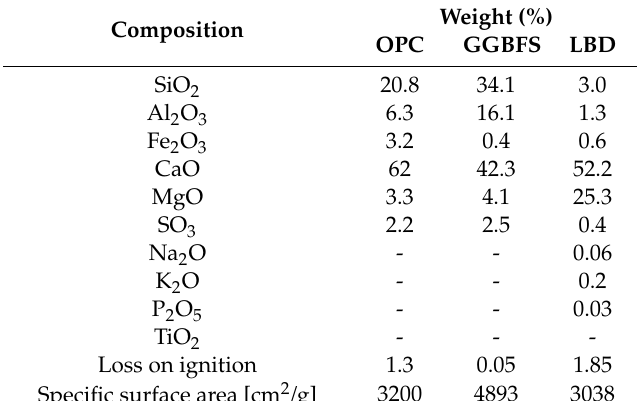
Table 1. Chemical and physical properties of Ordinary Portland cement (OPC), ground granulated blast furnace slag (GGBFS), and light-burnt dolomite (LBD).